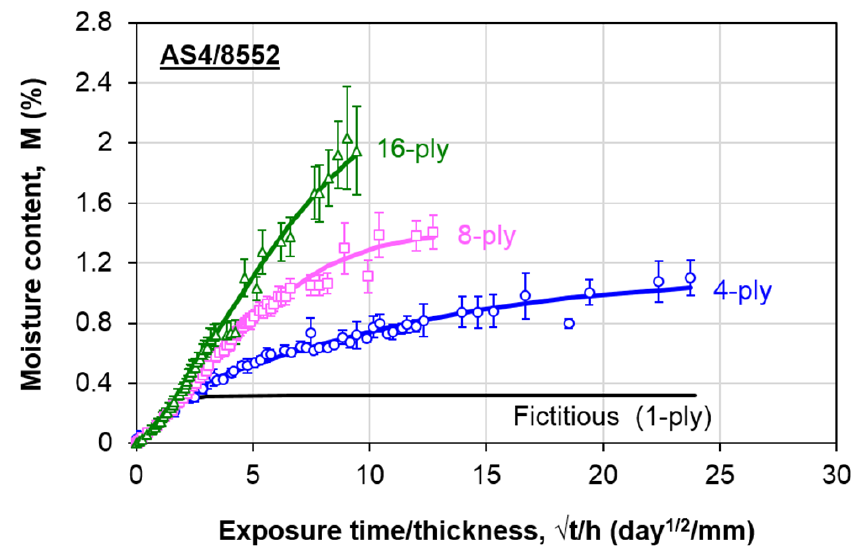
Figure 7. Experimental and fitted water absorption behavior of AS4/8552 carbon/epoxy composite